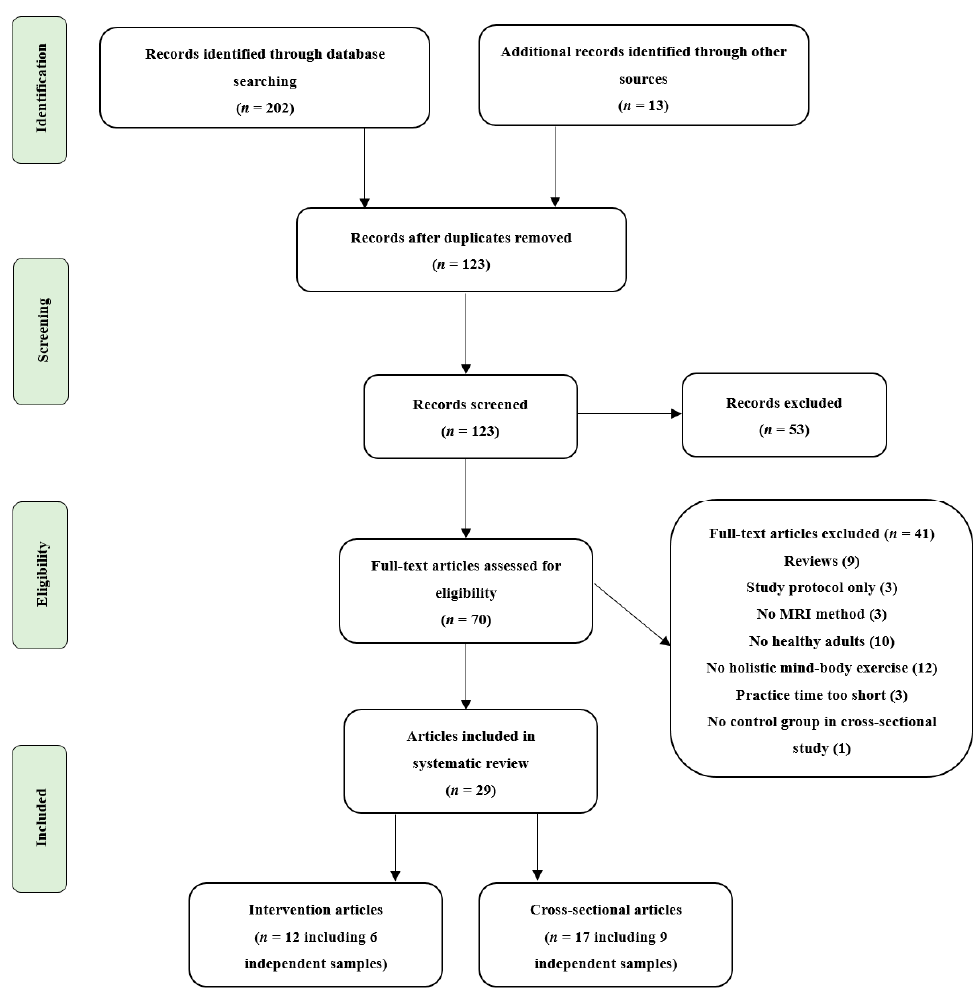
Figure 1. Flow chart of the study selection process for the systematic review.